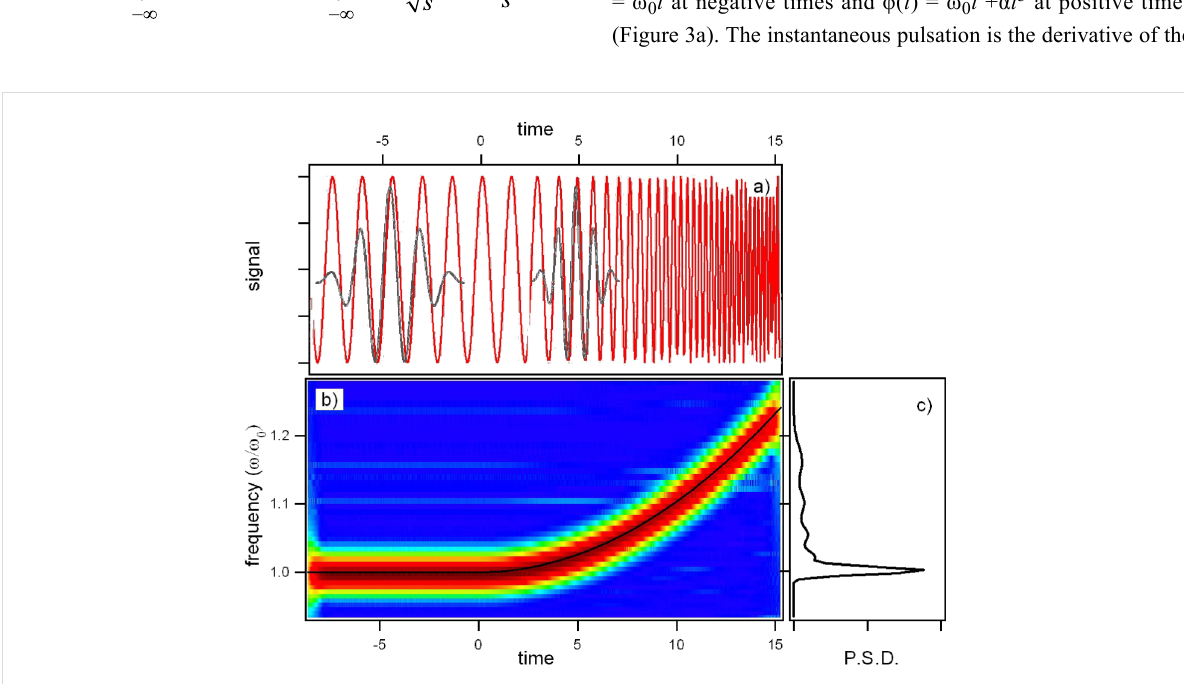
Figure 3: Comparison between the Fourier transform and the wavelet transform analysis. a) The time signal, a cosine function for negative times and a cosine with quadratic chirp for positive times. Two daughter wavelet functions with different dilations and delays are superposed to the signal to show the local resemblance between signal and wavelet. b) Wavelet transform of the temporal trace represented in a) showing the evolution of the signal frequency. The black line is the calculated instantaneous frequency. c) Fourier transform (power spectral density) of the signal represented in a). Only an average of the signal frequencies is